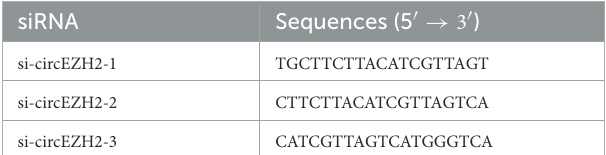
TABLE 1 Primers used in this